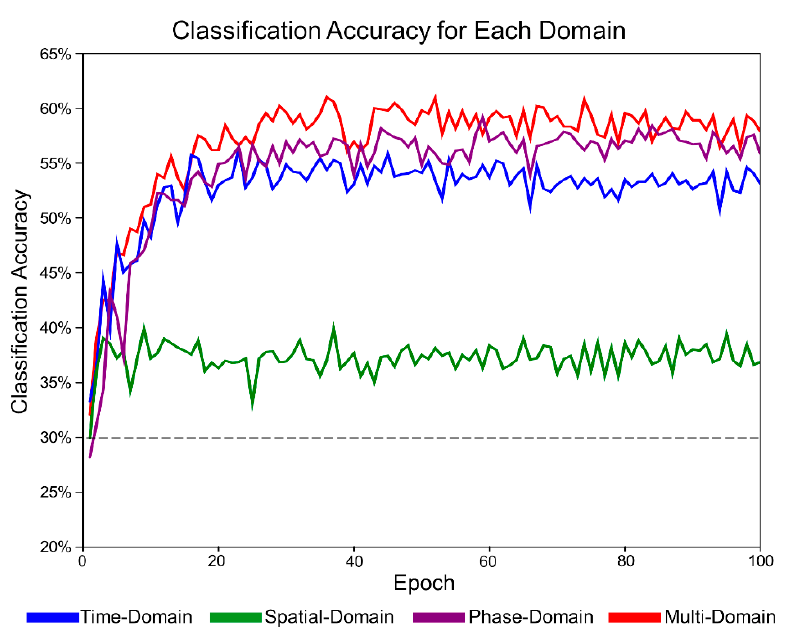
Figure 3. Classification accuracy of the MD-CNN in each domain for S6 with the BCI Competition IV dataset 2a: time-domain (blue), spatial-domain (green), phase-domain (purple), and multi-domain representation (red). The horizontal dotted line indicates the chance level.